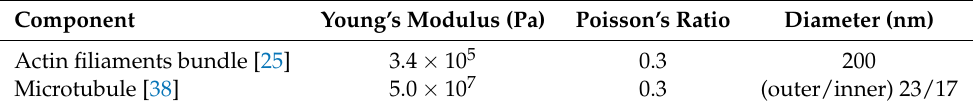
Table 1. Estimated elastic and geometric properties of the cytoskeletal